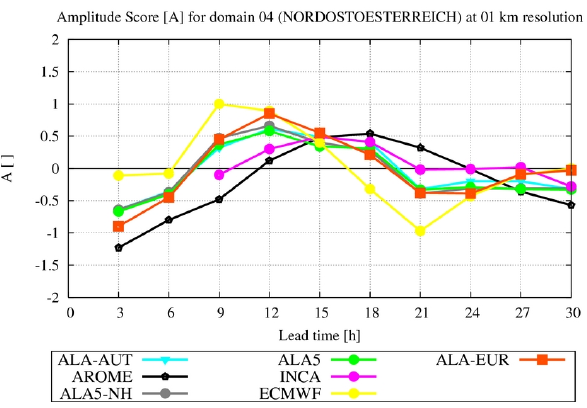
Figure 4. Mean values for SAL amplitude component A as a function of lead time for di ff erent models (verification period 20090601–20090731).